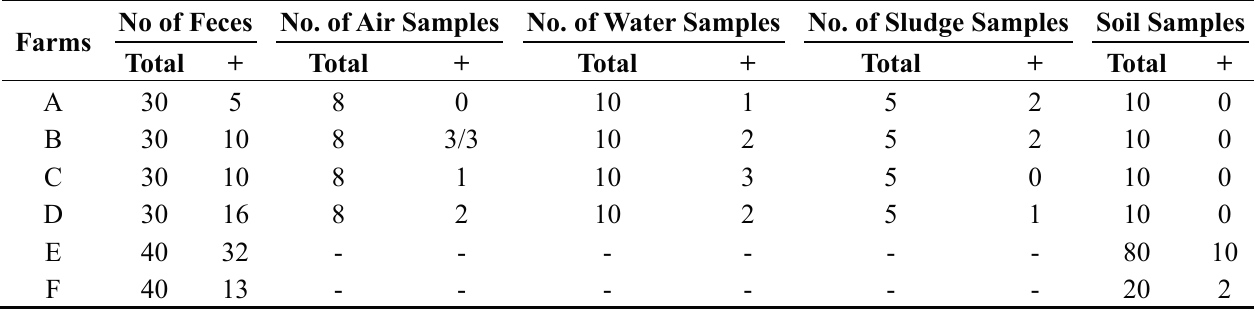
Table 1. No. of samples (total) and ESBL-positive samples (+) from six pig farms. No of Feces Farms